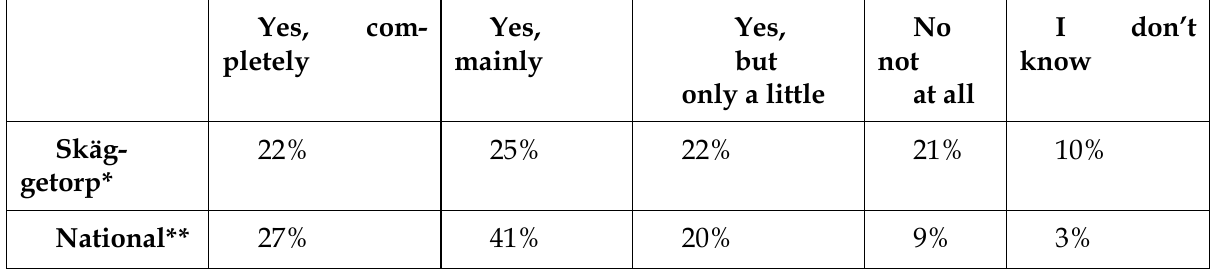
Table 2. Feeling included in digital society.